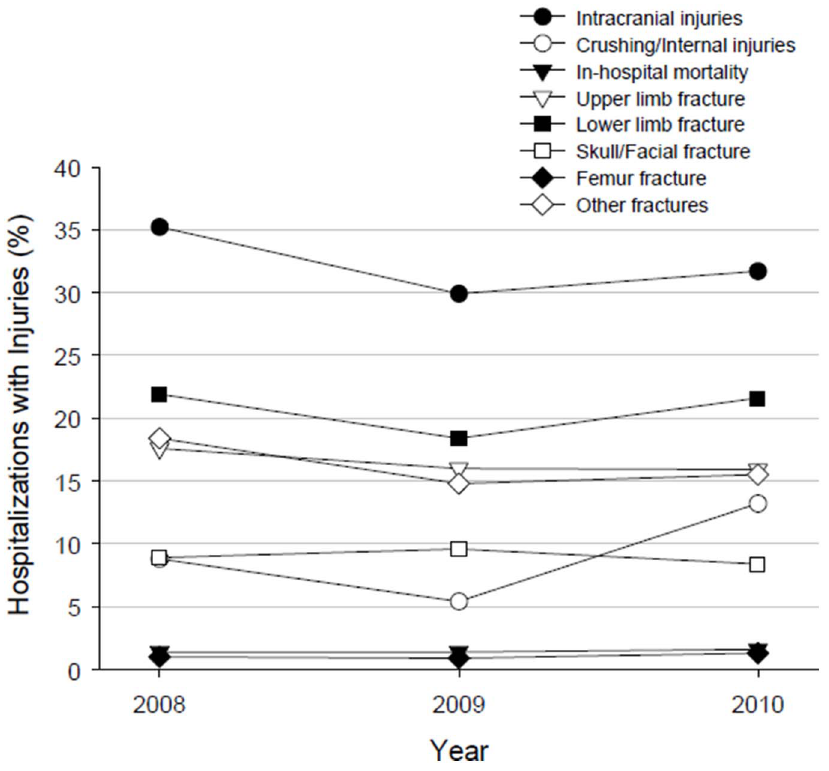
Figure 2. Common types of Injuries in Hospitalized Children.